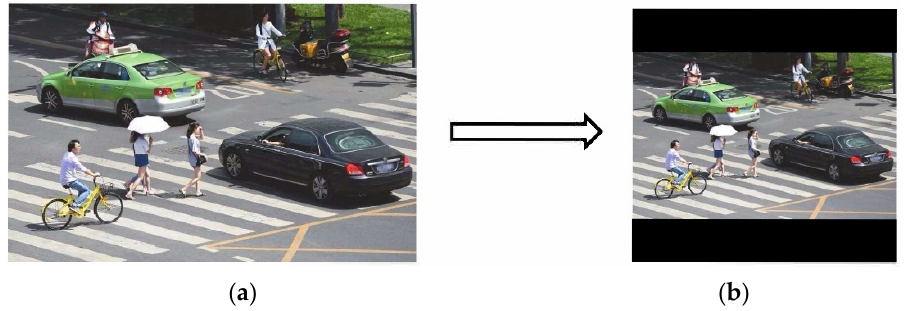
Figure 4. Conventional scaling and filling method. ( a ) Original image: 800 × 600; ( b ) scaled image: 416 × 416 .